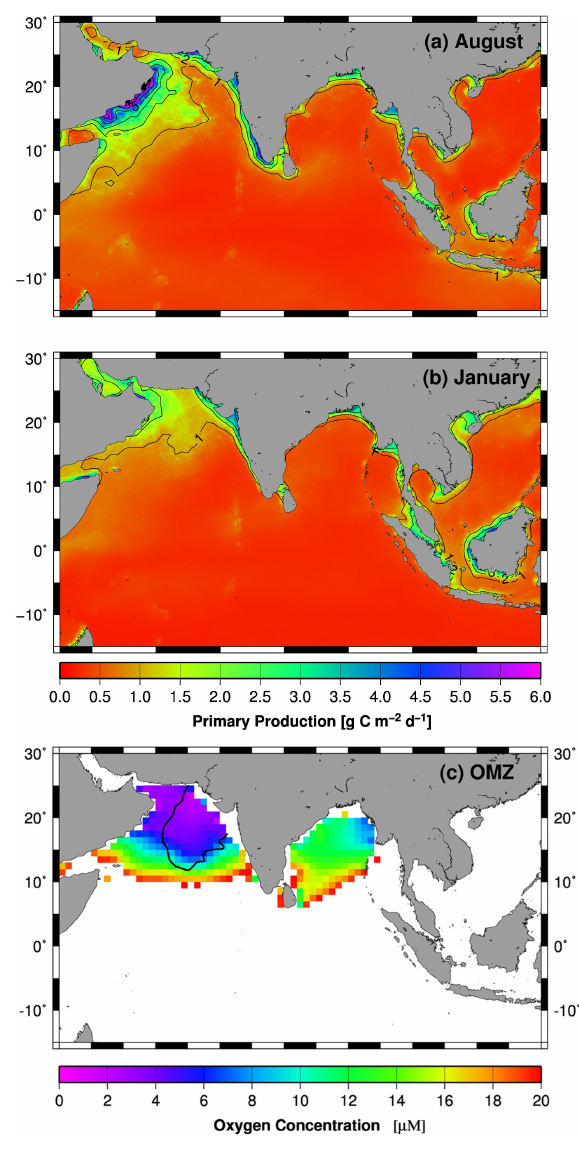
Figure 3. (a, b) Monthly mean primary production rates (Behren- feld and Falkowski, 1997) covering the periods between 2002 and 2014. (c) Minimum oxygen concentration in the water column of the Indian Ocean. Oxygen concentrations > 20µM are indicated by the white color. The data were obtained from the World Ocean At- las 2013 (Boyer et al., 2013). The black line indicates the extent of the secondary nitrate maximum (SNM) in 1997 (Rixen et al., 2014). The maps were produced with Generic Mapping